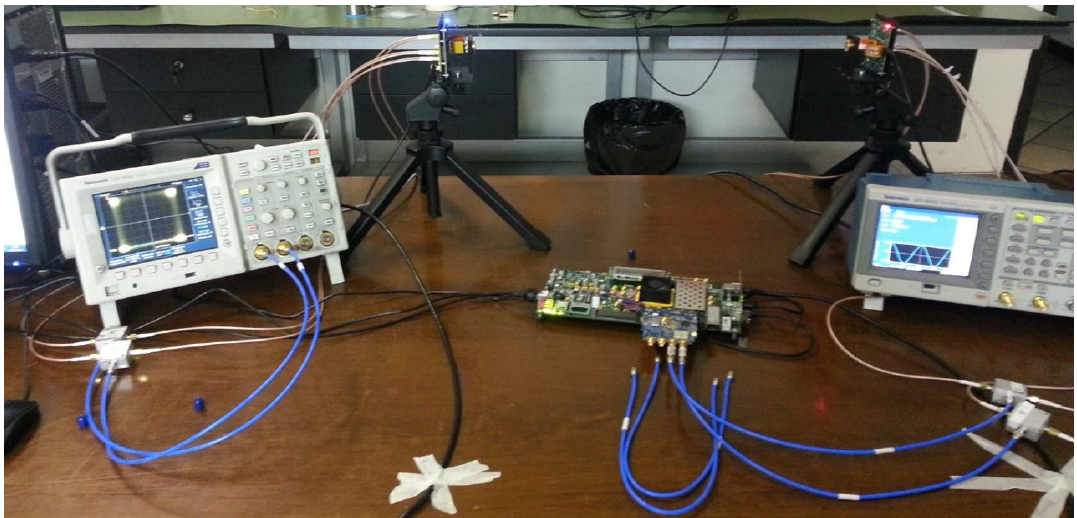
Figure 6. Picture of the experimental setup using the Zynq Ultrascale + MPSoC ZCU102 platform baseband system interconnected to the PEM003 radio system, operating in QPSK modulation.